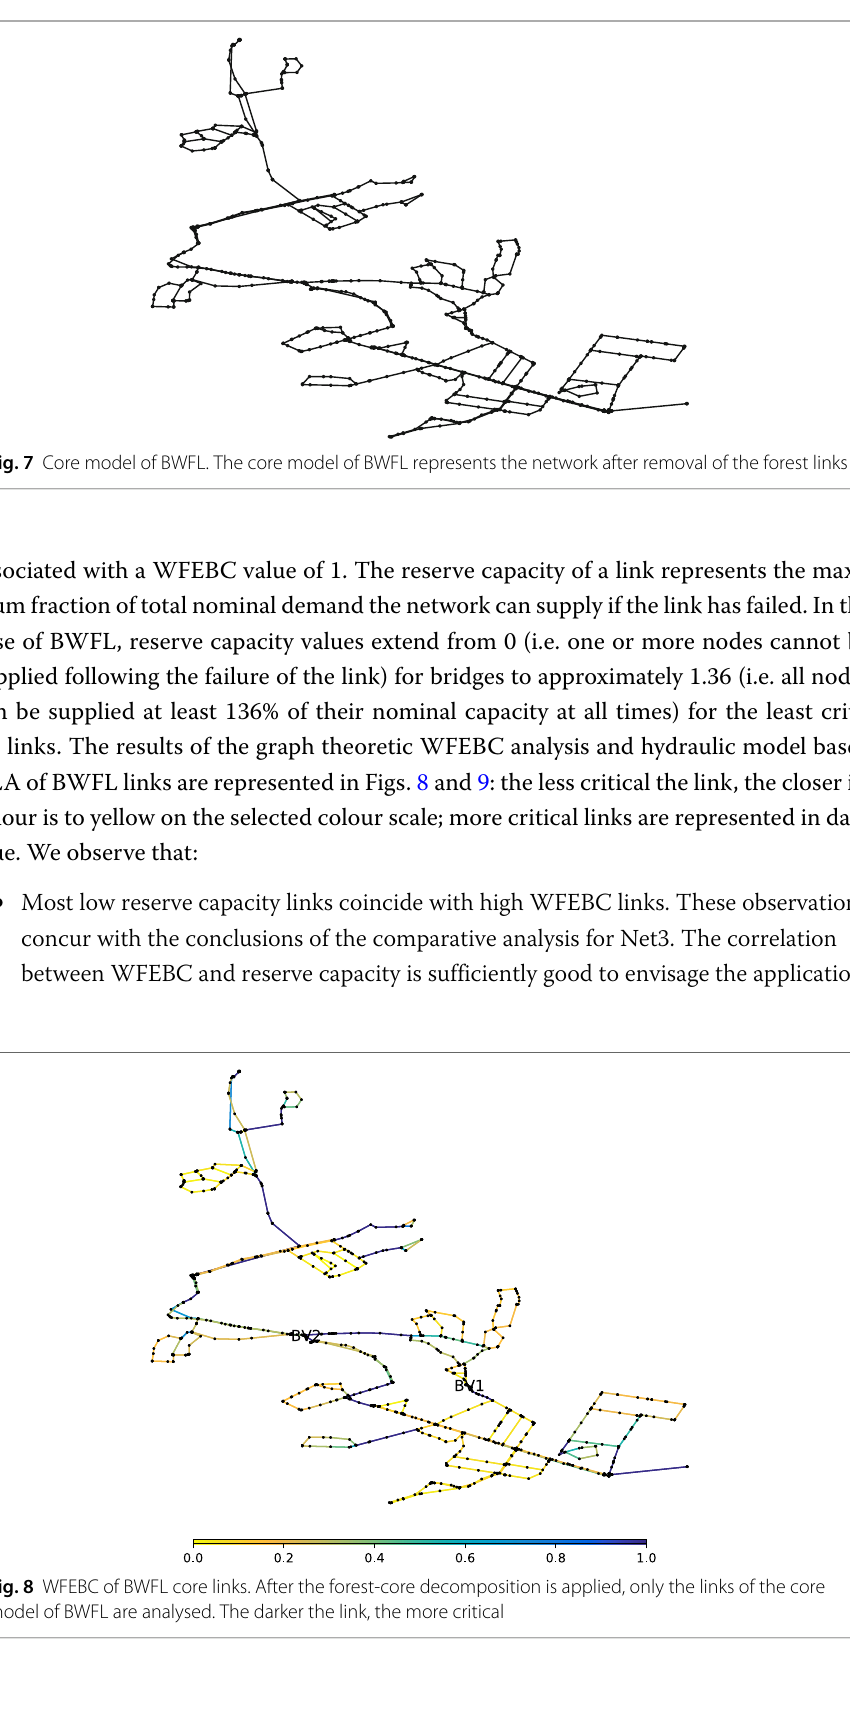
Fig. 8 WFEBC of BWFL core links. After the forest-core decomposition is applied, only the links of the core model of BWFL are analysed. The darker the link, the more